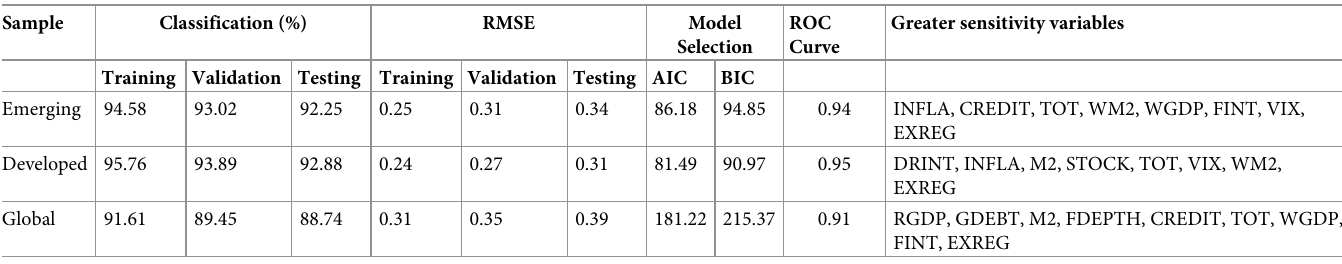
Table 8. Results of accuracy evaluation for SS1. Sample Classification (%) RMSE Model